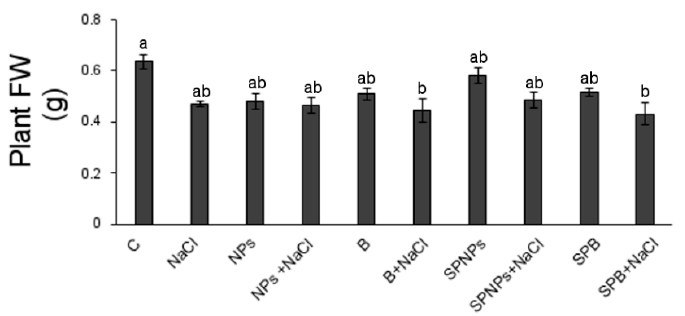
Figure 5. Fresh weight of plants of T. turgidum L. ssp. durum cv. Cappelli without priming and salt treatment (C), with salt treatment without priming (NaCl), with ZnO treatment in the root zone (nanoparticles, NPs or bulk form, B), with ZnO priming in the root zone with salt treatment (NPs + NaCl or B + NaCl), with ZnO treatment as a leaf spray (SPNPs or SPB), and with ZnO priming as a leaf spray with salt treatment (SPNPs + NaCl or SPB + NaCl): values are means of at least three replicates ± SE. When ANOVA highlighted significant differences, Tukey’s post hoc test was performed, and different letters indicate significantly different mean values at p < 0.05.